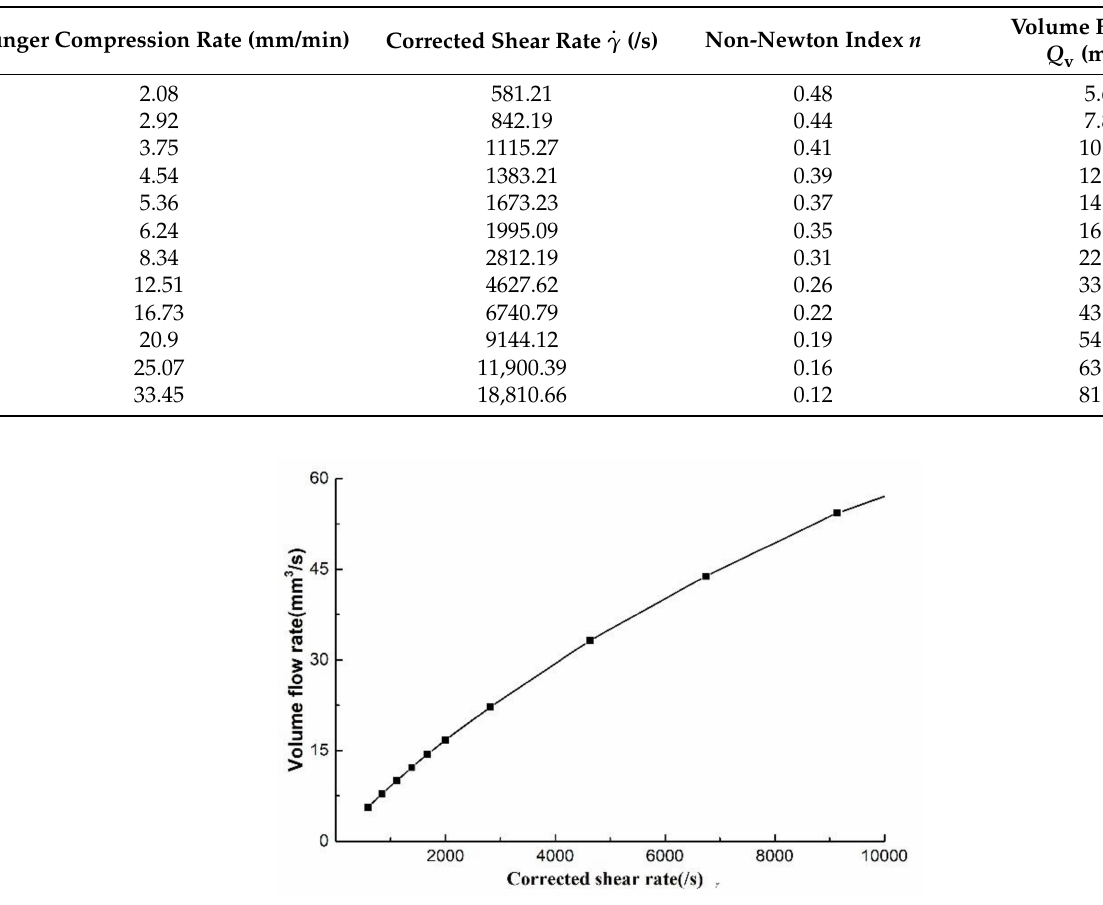
Figure 8. The relationship between shear rate and volume flow